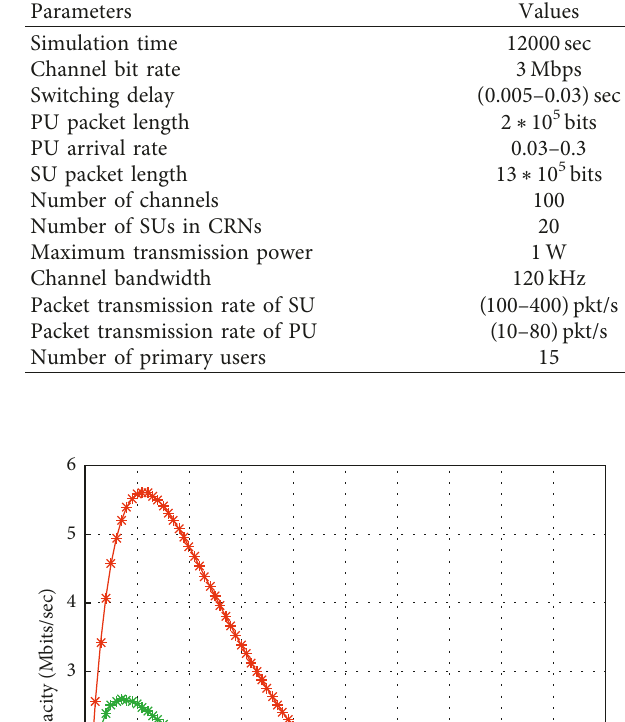
Table 3: Summary of abbreviations used in the protocol. Symbol